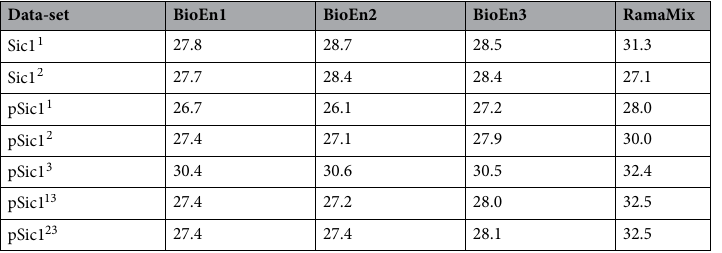
Table 4. Resulting gyration radii (Å) calculated from the individual gyration radii of the conformations selected by the BioEn and RamaMix analyses. The data-sets Sic1 obtained using the approach TAiBP on the proteins Sic1 and pSic1. The data-sets pSic1 obtained by pooling together the conformations of pSic1 3 pSic1